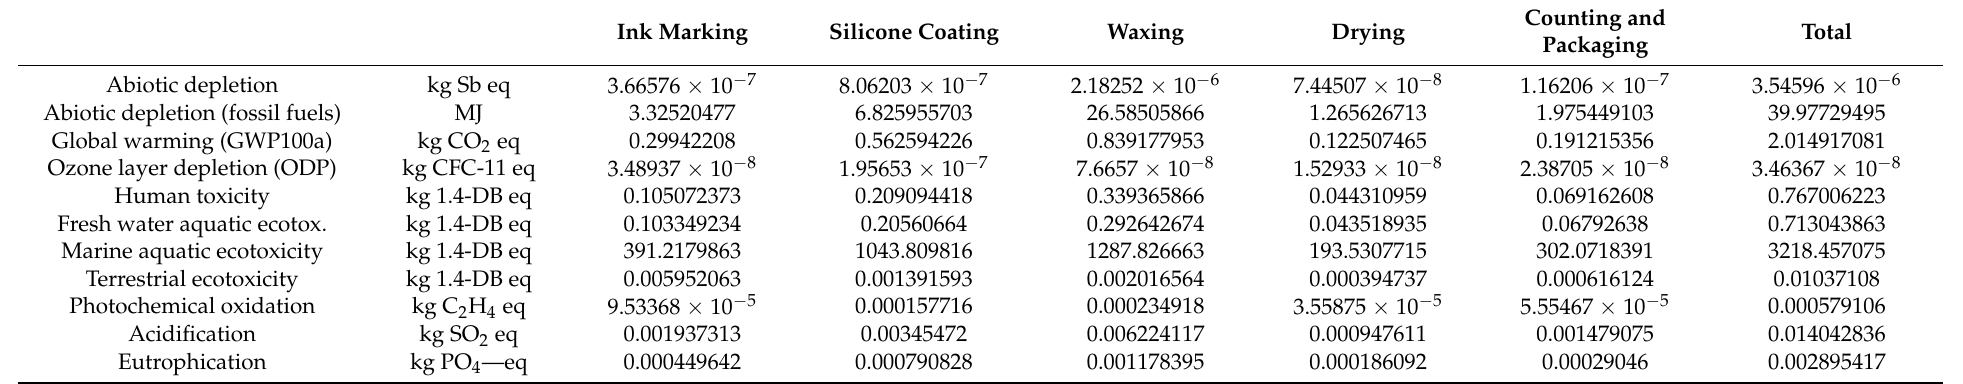
Table 16. Impact of stage 3 broken down by activities for the manufacturing process of 2-piece turning stoppers of 24 mm in diameter and 44 mm in length. Ink Marking Silicone Coating Waxing Drying